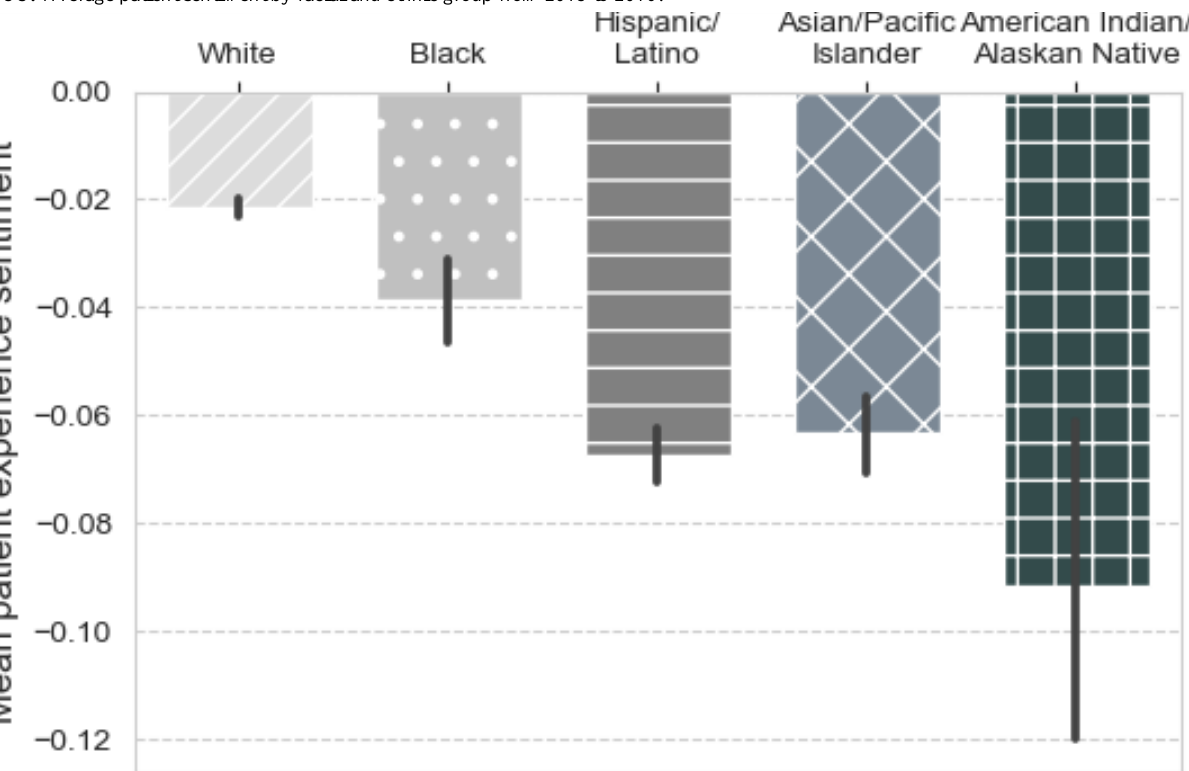
Figure 3. Average patient sentiment by racial and ethnic group from 2013 to